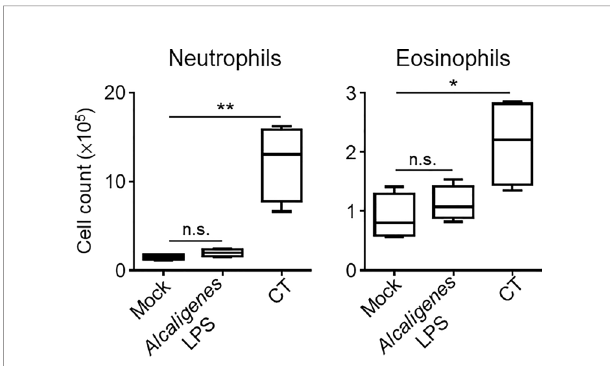
FIGURE 6 | Alcaligenes LPS induced little in fl ammation at the site of administration. Mice were nasally immunized three times with OVA alone (Mock) or with OVA plus Alcaligenes LPS or CT. One week after the fi nal immunization, the number of neutrophils (gated on: 7AAD − CD45 + CD11c + Ly6G + ) and eosinophils (gated on: 7AAD − CD45 + CD11c + Siglec-F + ) in the nasal passage were determined by fl ow cytometric analysis ( n = 4 per group). Data are representative of two independent experiments and analyzed by one-way ANOVA (* p < 0.05; ** p < 0.01; n.s., not signi fi